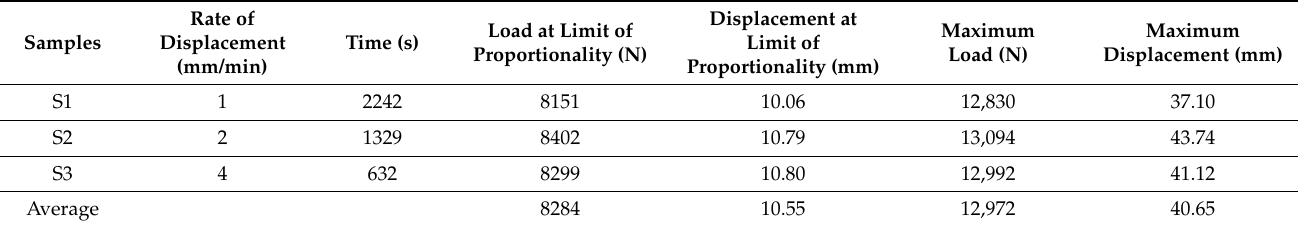
Table 2. Mechanical test